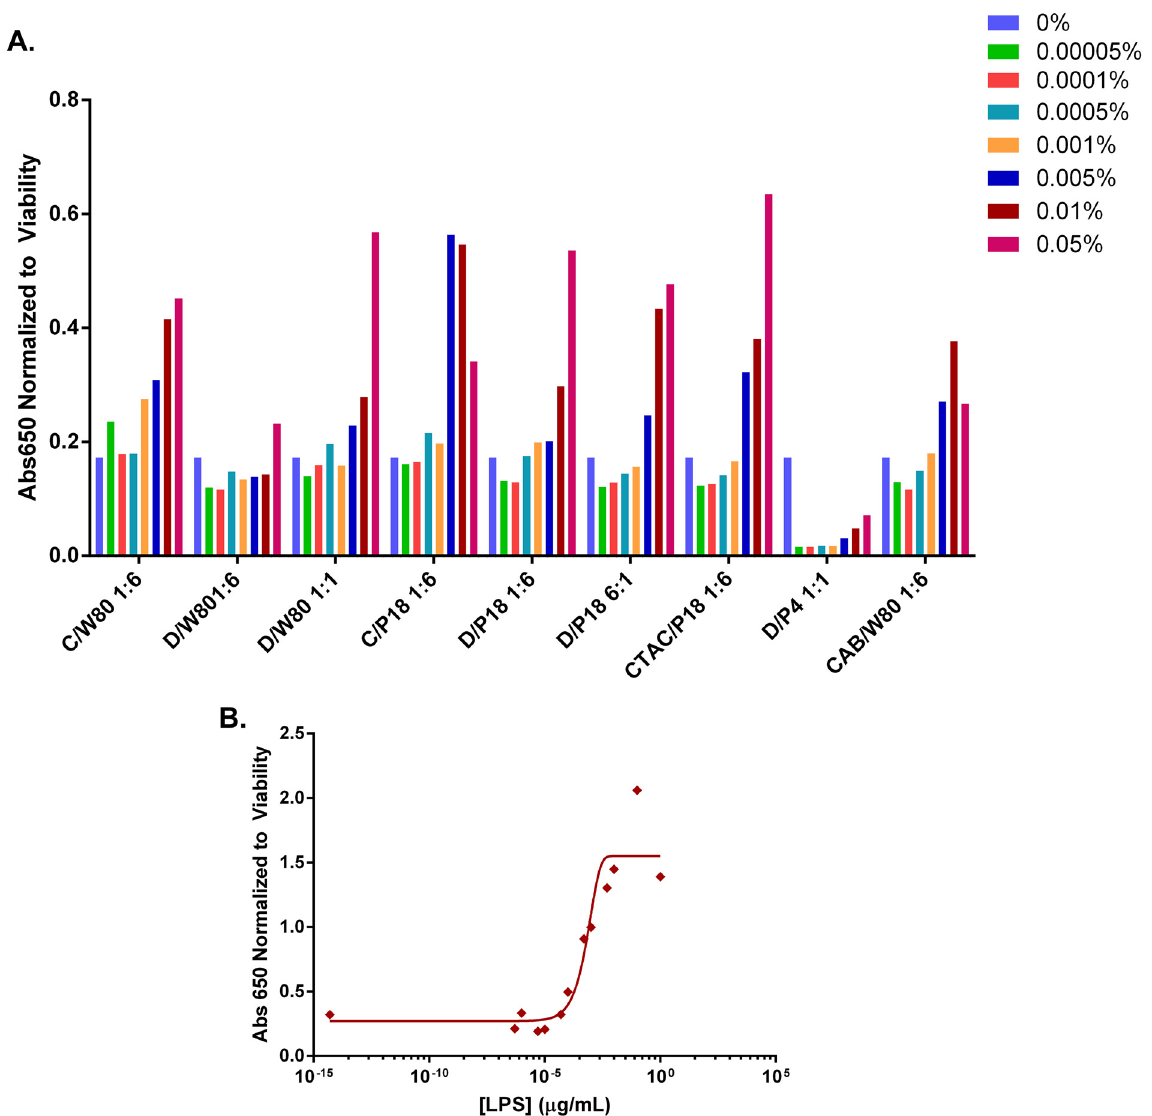
Fig 6. NF- κ B activation for RawBlue macrophages. Cells were treated for 24 h at 37°C with increasing concentrations of (A) NE, or (B) LPS. The level of activation was detected by SEAP activity as measured by absorbance at 650 nm normalized to the relative number of viable cells remaining after the 24 h treatment assessed by XTT (S4 Fig). (Abbreviations CPC (C), Tween80 (W80), DODAC (D), P188 (P18), P407